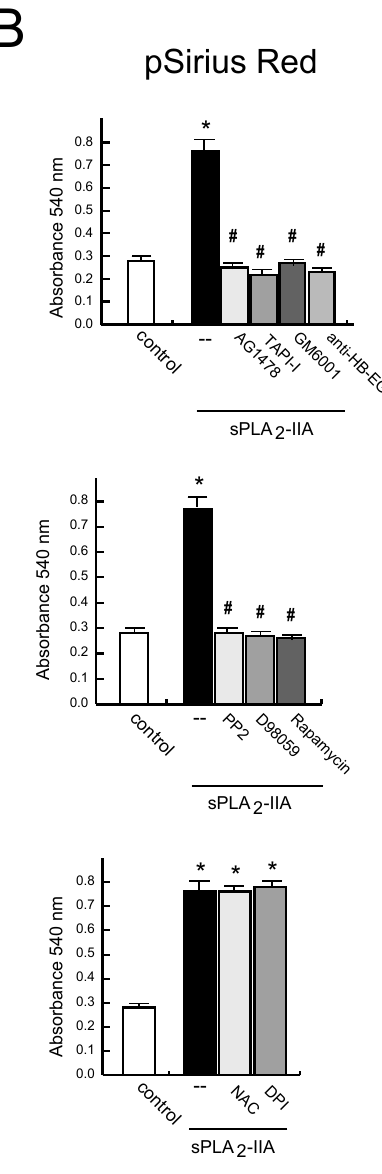
Figure 6. sPLA 2 -IIA induces collagen production in cardiac fibroblast (CFs). CFs pretreated without / with the indicated inhibitors, were stimulated with 1 µ g / mL of sPLA 2 -IIA. ( A ) After 24 h, collagen I protein expression was evaluated on cells by flow cytometry. Untreated (solid black curves) and sPLA 2 -IIA-treated (solid dark grey curves) CFs were compared with isotype controls (solid light grey curves). Representative histograms are shown, n = 3. ( B ) After 72 h, total collagen accumulation on CFs cultures was stained with picro-Sirius red and quantified by spectrophotometric analysis. Bar graphs represent the mean ± SD; n = 3. * p < 0.001 vs. control cells, # p < 0.001 vs. sPLA2-IIA-treated cells.